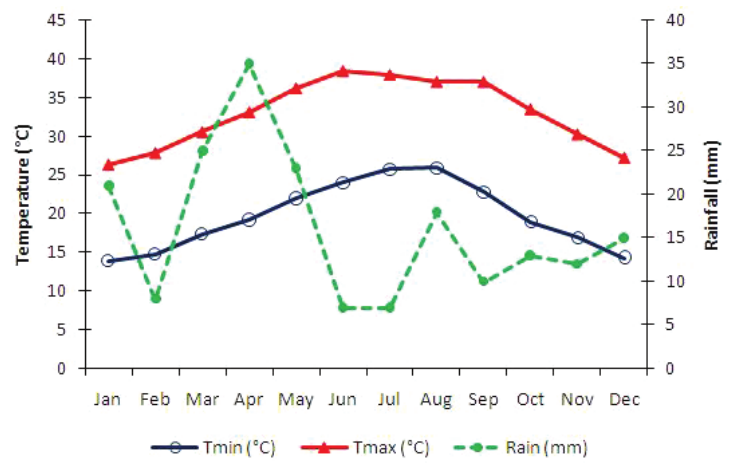
Figure 2. Monthly average temperatures and rainfall in 50 years (1950–2000). In Jabal Shada al-A‘la Nature Reserve (Worldclim database: